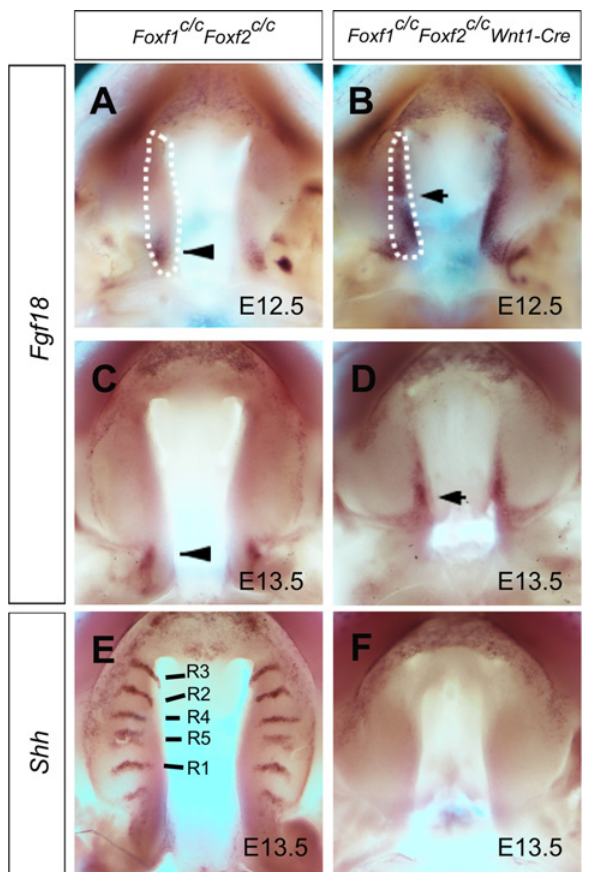
Fig 7. Comparison of expression of Fgf18 and Shh mRNAs in the palatal shelves in Foxf1 c/c Foxf2 c/c control and Foxf1 c/c Foxf2 c/c Wnt1-Cre mutant embryos. (A, B) Whole-mount in situ hybridization detection of Fgf18 mRNAs in the developing palatal shelves in Foxf1 c/c Foxf2 c/c control (A, C) and Foxf1 c/c Foxf2 c/c Wnt1-Cre mutant (B, D) embryos at E12.5 (A, B) and E13.5 (C, D). White dashes demarcate the palatal shelf on the right side. Arrowhead (A, C) and arrow (B, D) point to the Fgf18 expression domains in the control and mutant palatal shelves, respectively. (E, F) Whole-mount in situ hybridization detection of Shh mRNAs in the developing palatal shelves in Foxf1 c/c Foxf2 c/c control (E) and Foxf1 c/c Foxf2 c/c Wnt1-Cre mutant (F) embryos at E13.5. Note that expression of Shh is lost in Foxf1 c/c Foxf2 c/c Wnt1-Cre mutant palatal